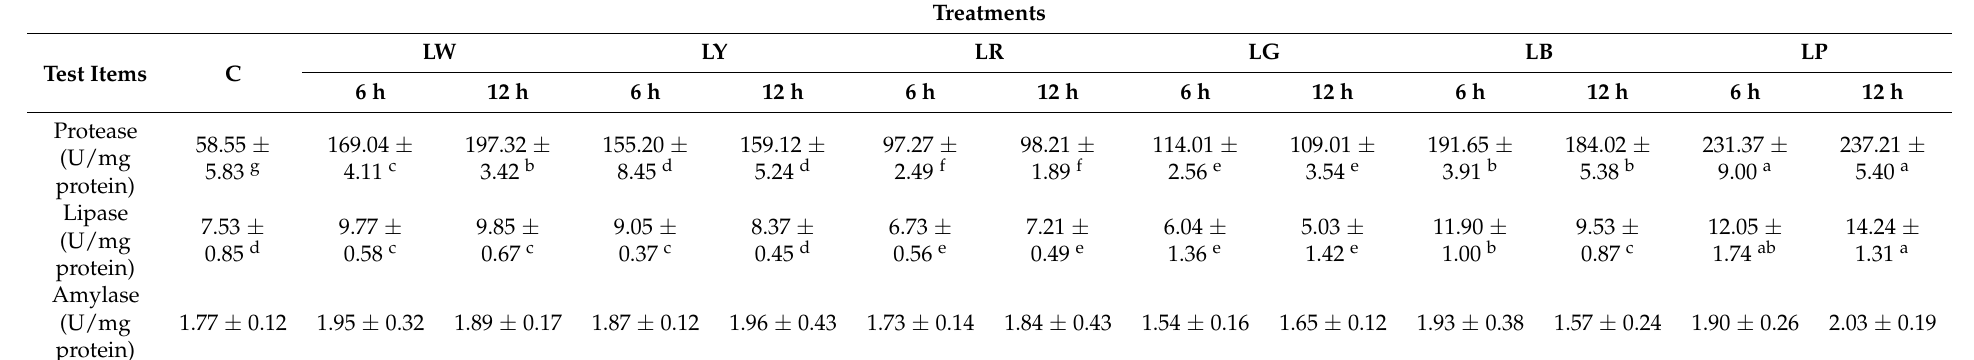
Table 5. Activity of digestive enzymes in Goniopora columna after 8 weeks of daily exposure to different light sources for 6 or 12 h.